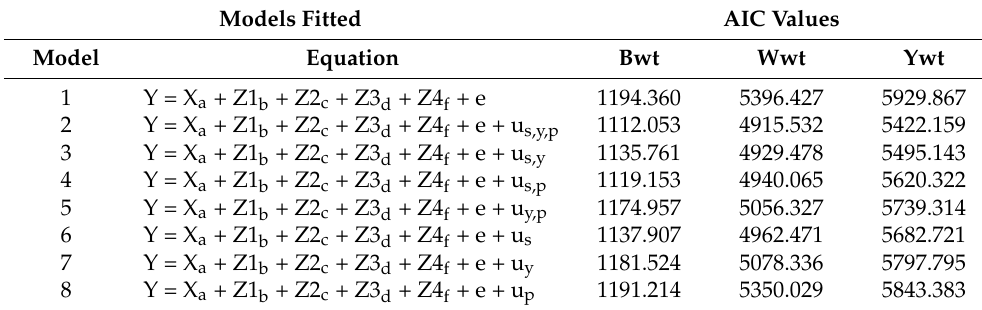
Table 2. A summary of models tested with their respective AIC values per